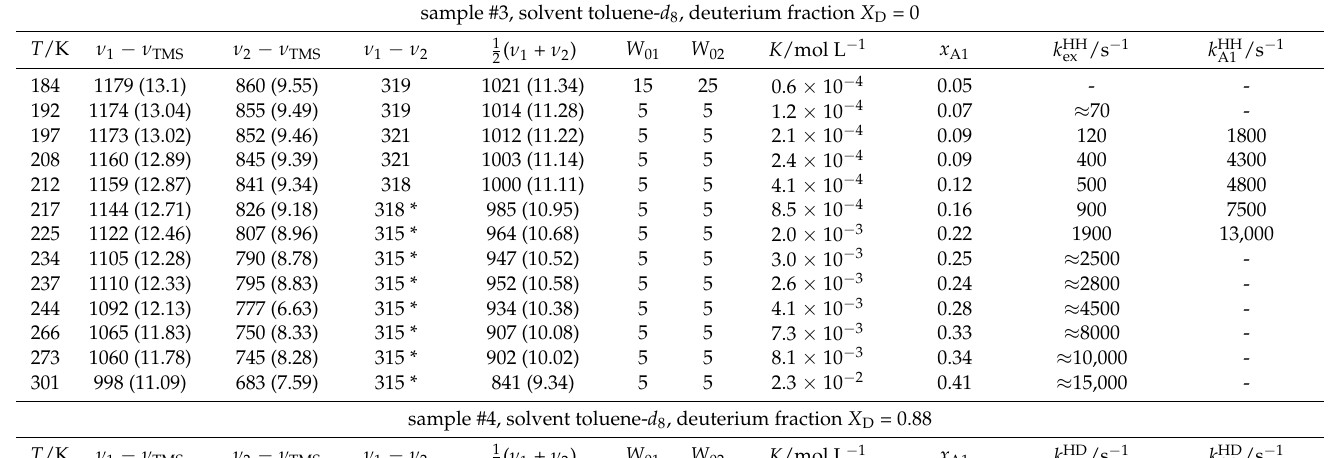
Table 2. 1 H NMR simulation parameters of tetramethyl reductic acid dissolved in CD 2 Cl 2 and toluene- d 8 in the presence of a degenerate